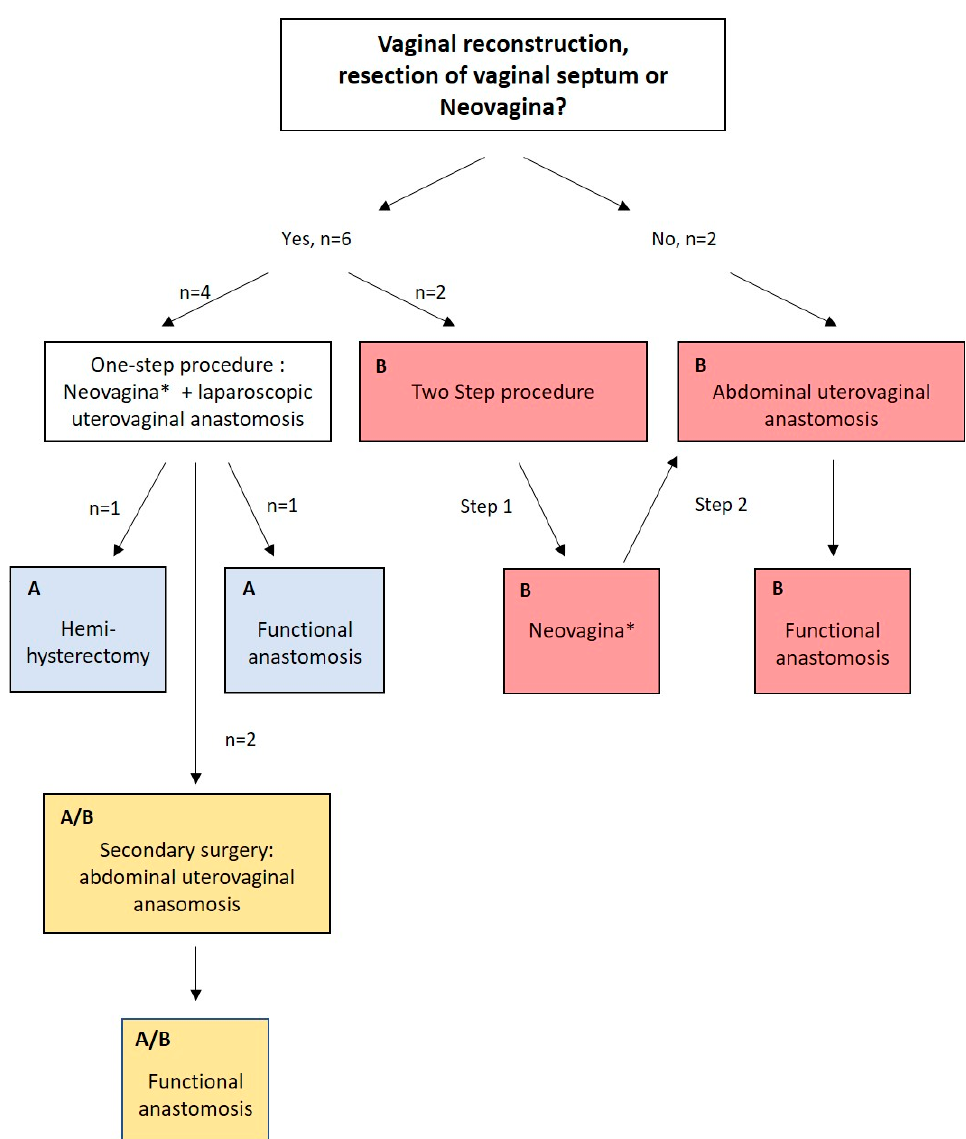
Figure 1. Surgical treatment algorithm. * Surgery for neovagina by modified McIndoe technique, vaginal reconstruction or resection of vaginal septum. (A) Method A: one-step creation of a neovagina* and simultaneous laparoscopic uterovaginal anastomosis procedure similar to the pull-through technique. (B) Method B: two-step/primary open abdominal technique: if necessary, creation of